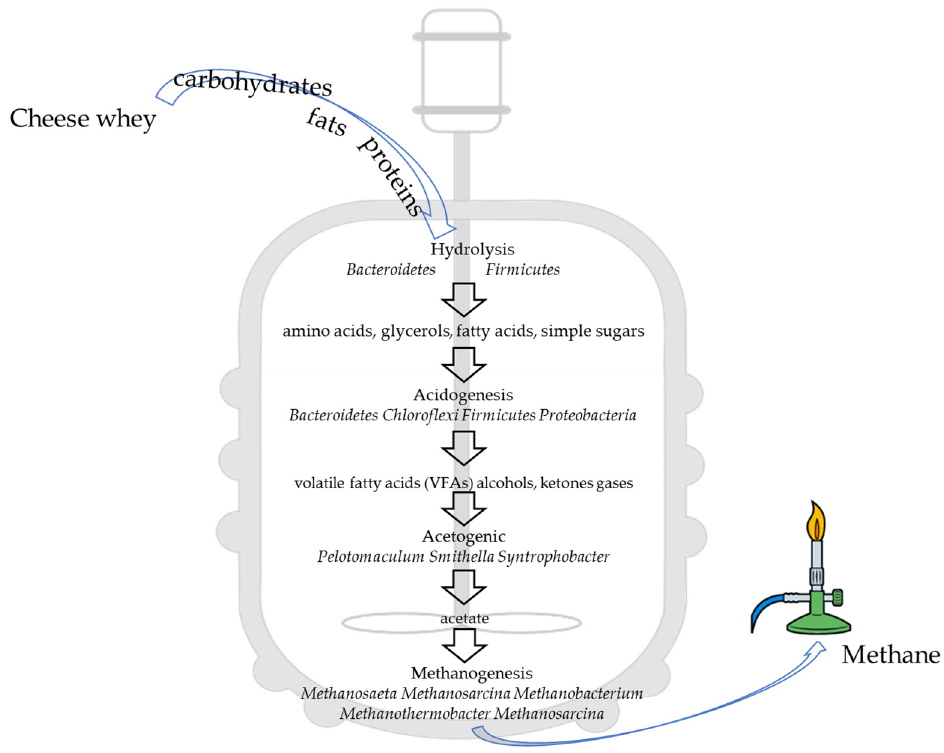
Figure 4. Main steps involved in anaerobic digestion processes.